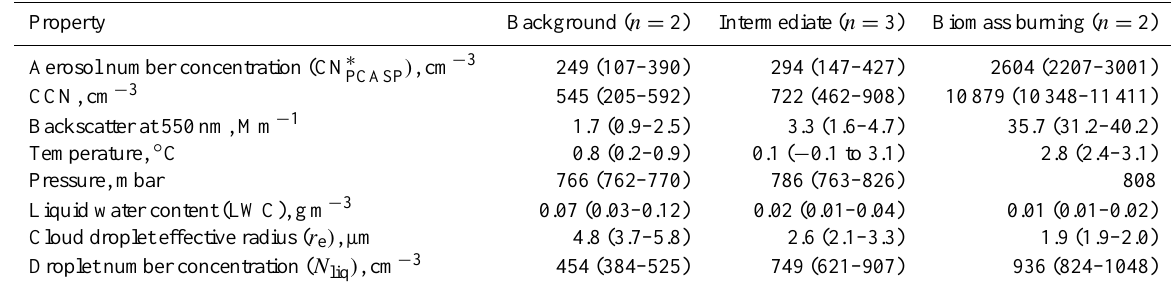
Table 8. Mean properties and ranges for the 1 July 2008 ARCTAS case study, including background, intermediate, and biomass burning cloud